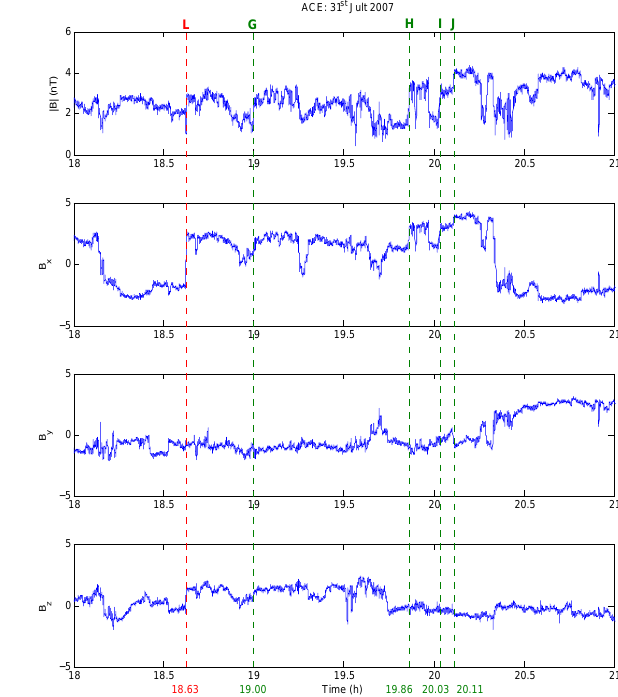
Fig. 5. Close-up view of the shocks presented in Fig. 3. Caption of Fig. 3 apply.